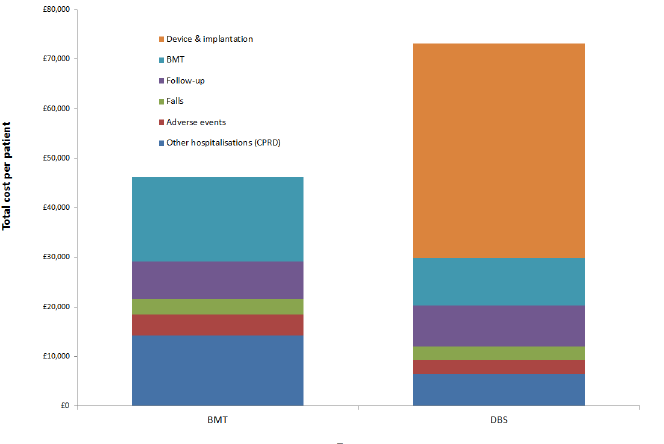
Fig 2. Cost breakdown by